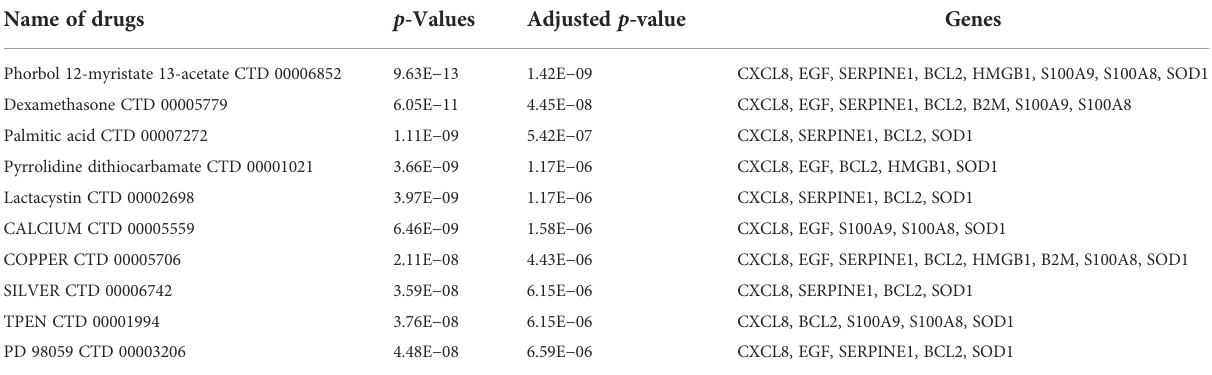
TABLE 6 Prediction of top 10 candidate drugs for Long COVID and ME/CFS. Name of